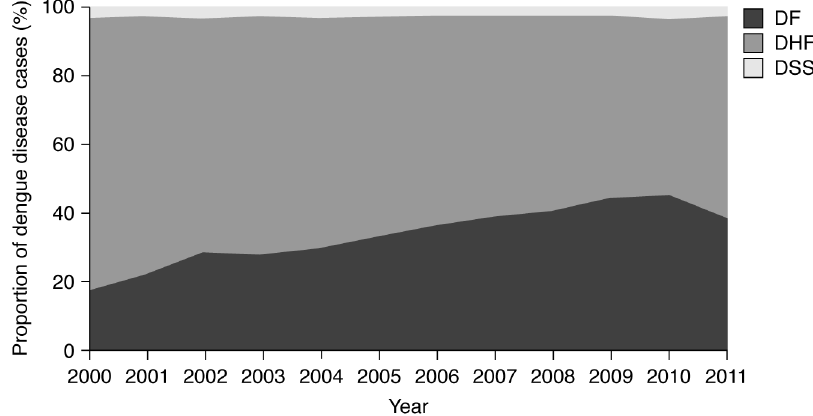
Figure 3. Reported cases of dengue fever, dengue haemorrhagic fever and dengue shock syndrome, Thailand, 2000–2011 [23–34]. The contribution of DSS to the total number of dengue disease cases remained relatively stable over the decade. Over the same period, the proportion of the total dengue disease cases classified as DF tended to increase year-on-year (with the exception of 2010–2011) whereas the contribution of DHF to the total number of dengue disease cases decreased. DF, dengue fever; DHF, dengue haemorrhagic fever; DSS, dengue shock syndrome.